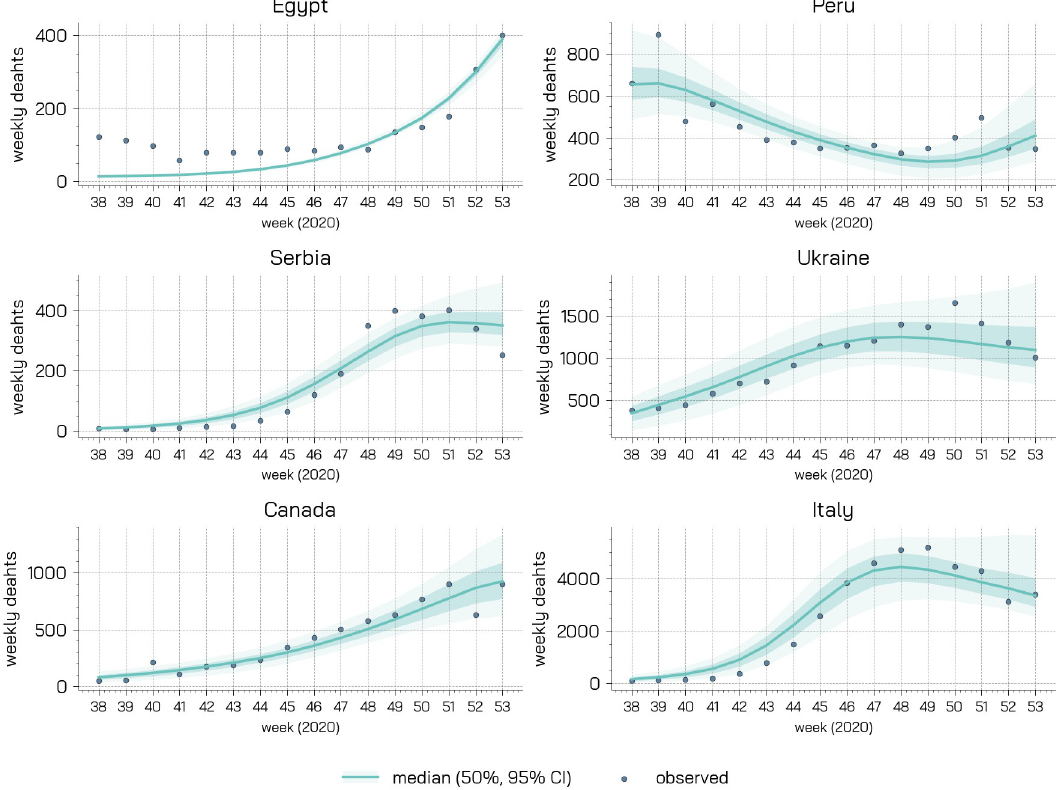
Fig 5. Calibration results. For each country we represent the observed and simulated weekly deaths (median, 50% and 95% confidence intervals).